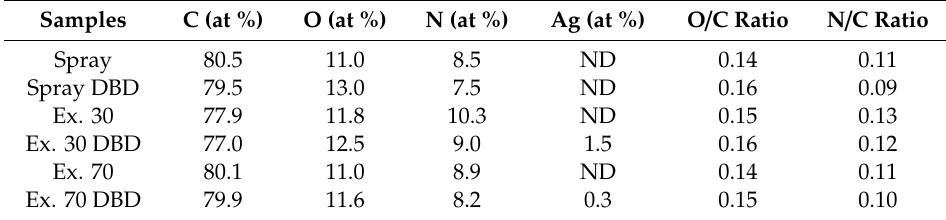
Table 1. Relative chemical compositions and atomic ratios of untreated and DBD plasma-treated PA66 fabrics with AgNPs deposited with spray and exhaustion at 30 ◦ C and 70 ◦ C methods.